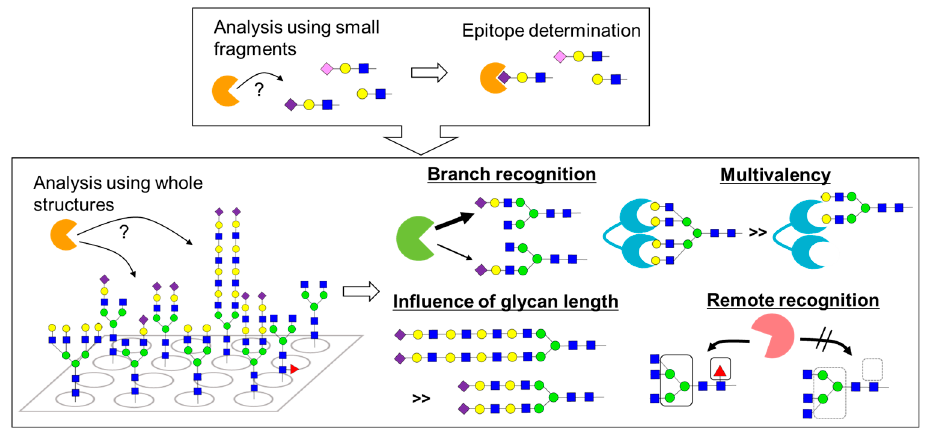
Figure 4. Analysis of glycan-lectin interaction using glycan arrays. Interaction analysis using small fragments, such as disaccharides and trisaccharides, revealed the epitope required for lectin recognition, whereas interaction analysis using whole structures of N -glycans revealed the significance of complexity of N -glycan structures; these analyses provided the insights into the differences in the lectin recognition of each branch, the improvement of affinity due to the inclusion of multiple recognition units (multivalent effect), the influence of chain length on affinity, and remote (heterovalent) recognition.